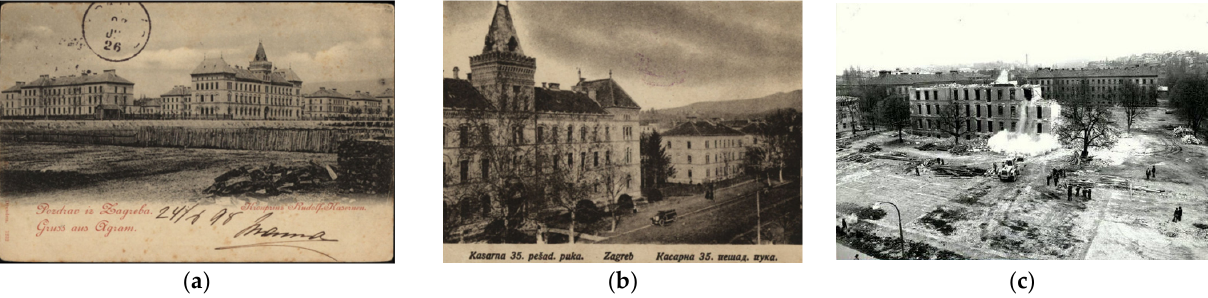
Figure 2. ( a ) Postcard from 1898 with a view of Rudolf’s barracks [30]; ( b ) Postcard from the beginning of the 20th century with case study building visible on the right [30]; ( c ) Demolition of part of the Rudolf’s barracks complex in the late 1970s.